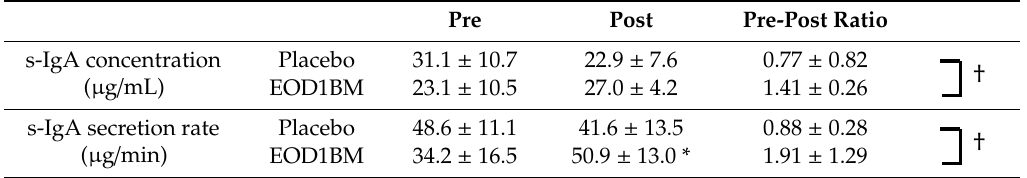
Table 1. Secretory immunoglobulin A (s-IgA) concentration and secretion rate in saliva before and after the ingestion of Euglena gracilis EOD-1 biomass (EOD1BM).